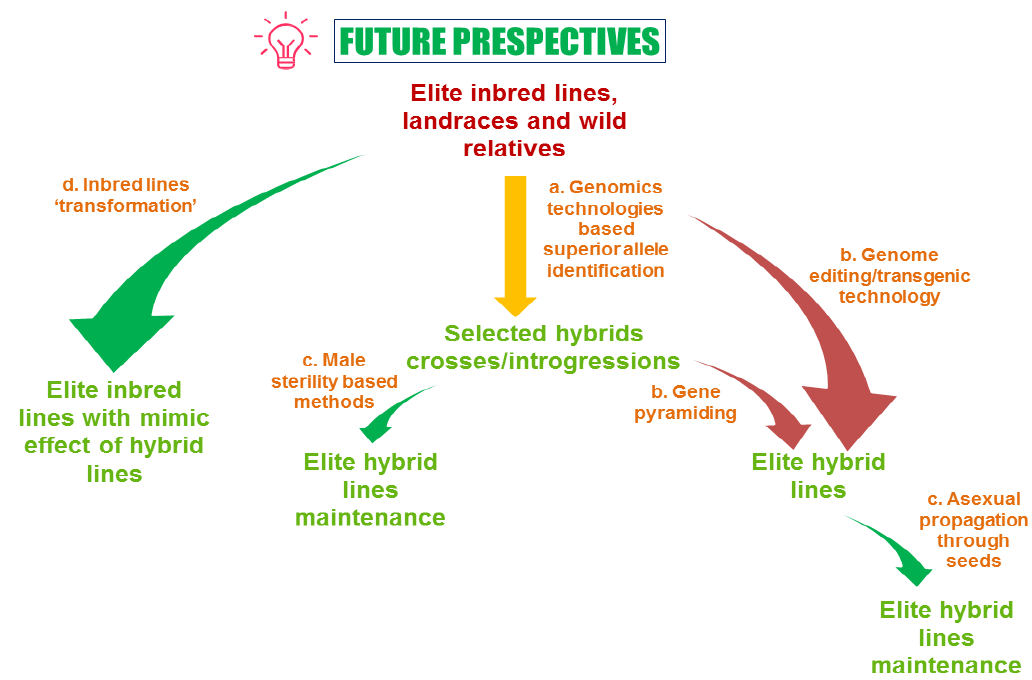
Figure 3. Future perspectives on heterosis breeding.